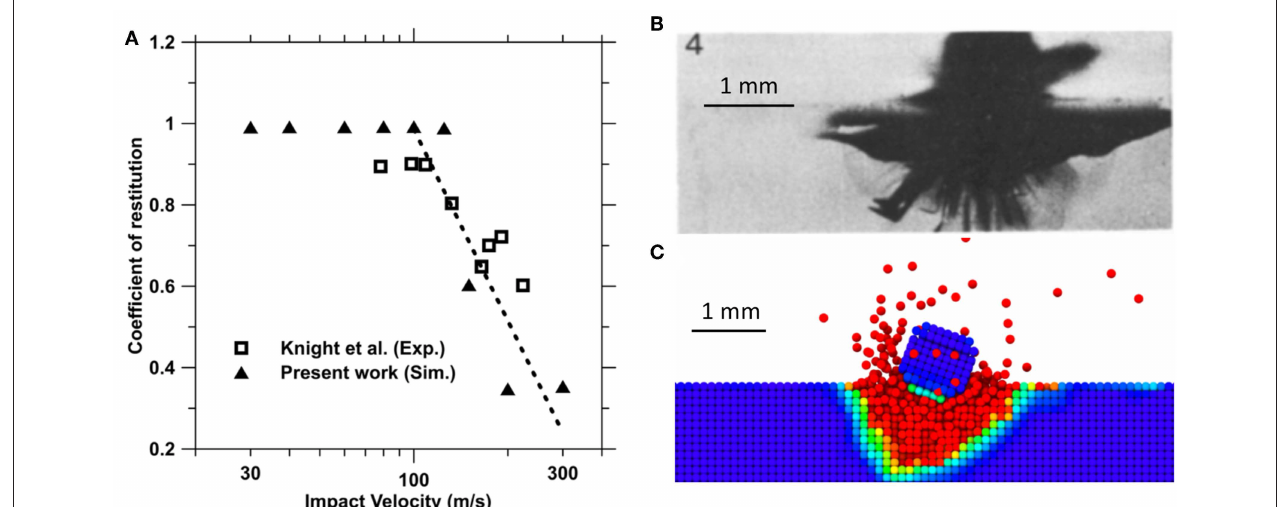
FIGURE 2 | (A) Simulated coefficient of restitution (filled triangles) of the impact compared with the previous experiments by Knight et al. (1977) (empty squares). The dotted line is a guide to eye. (B) Impact of steel sphere on soda-lime glass with an impact velocity of 200 m/s by Knight et al. (1977). (C) Simulation of the impact experiment by Knight et al. (1977) using peridynamics. Red color represents damaged